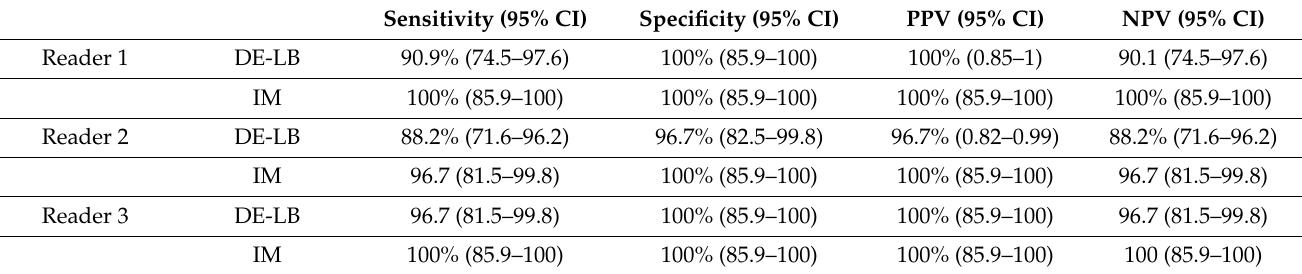
Table 2. Diagnostic performance of DECT vs. DE-LB to diagnose intraabdominal hematomas.